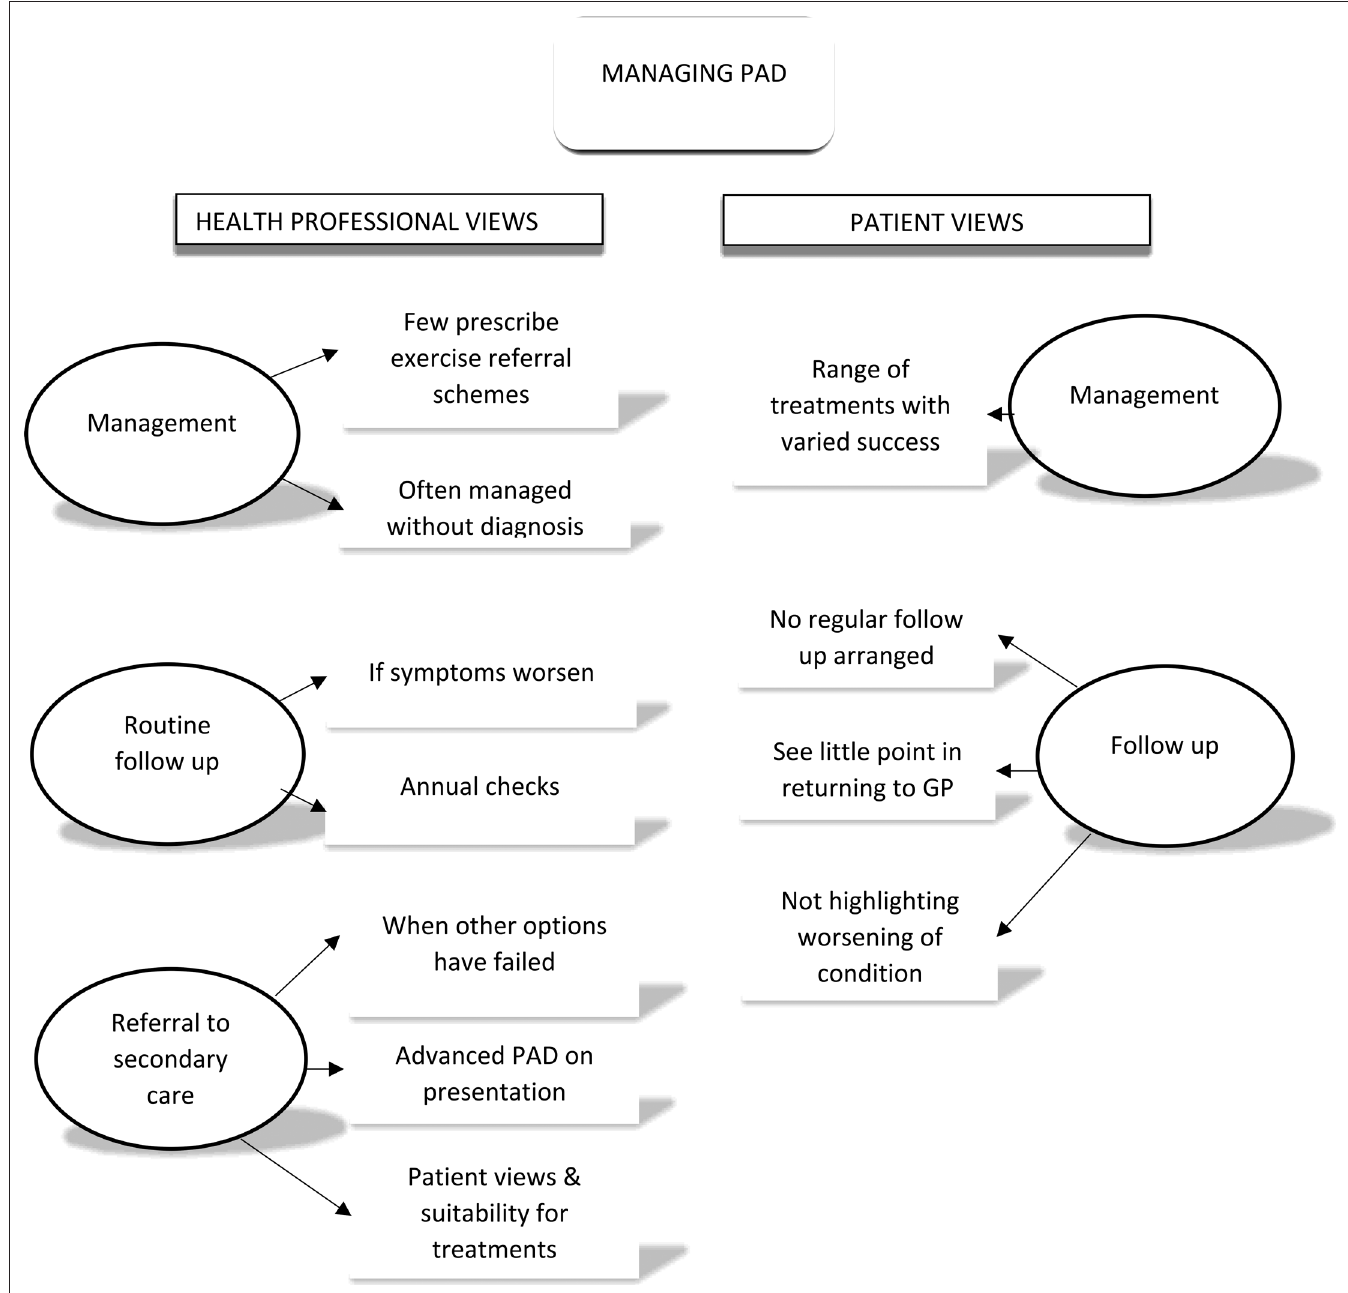
Figure 2 Themes: managing peripheral arterial disease